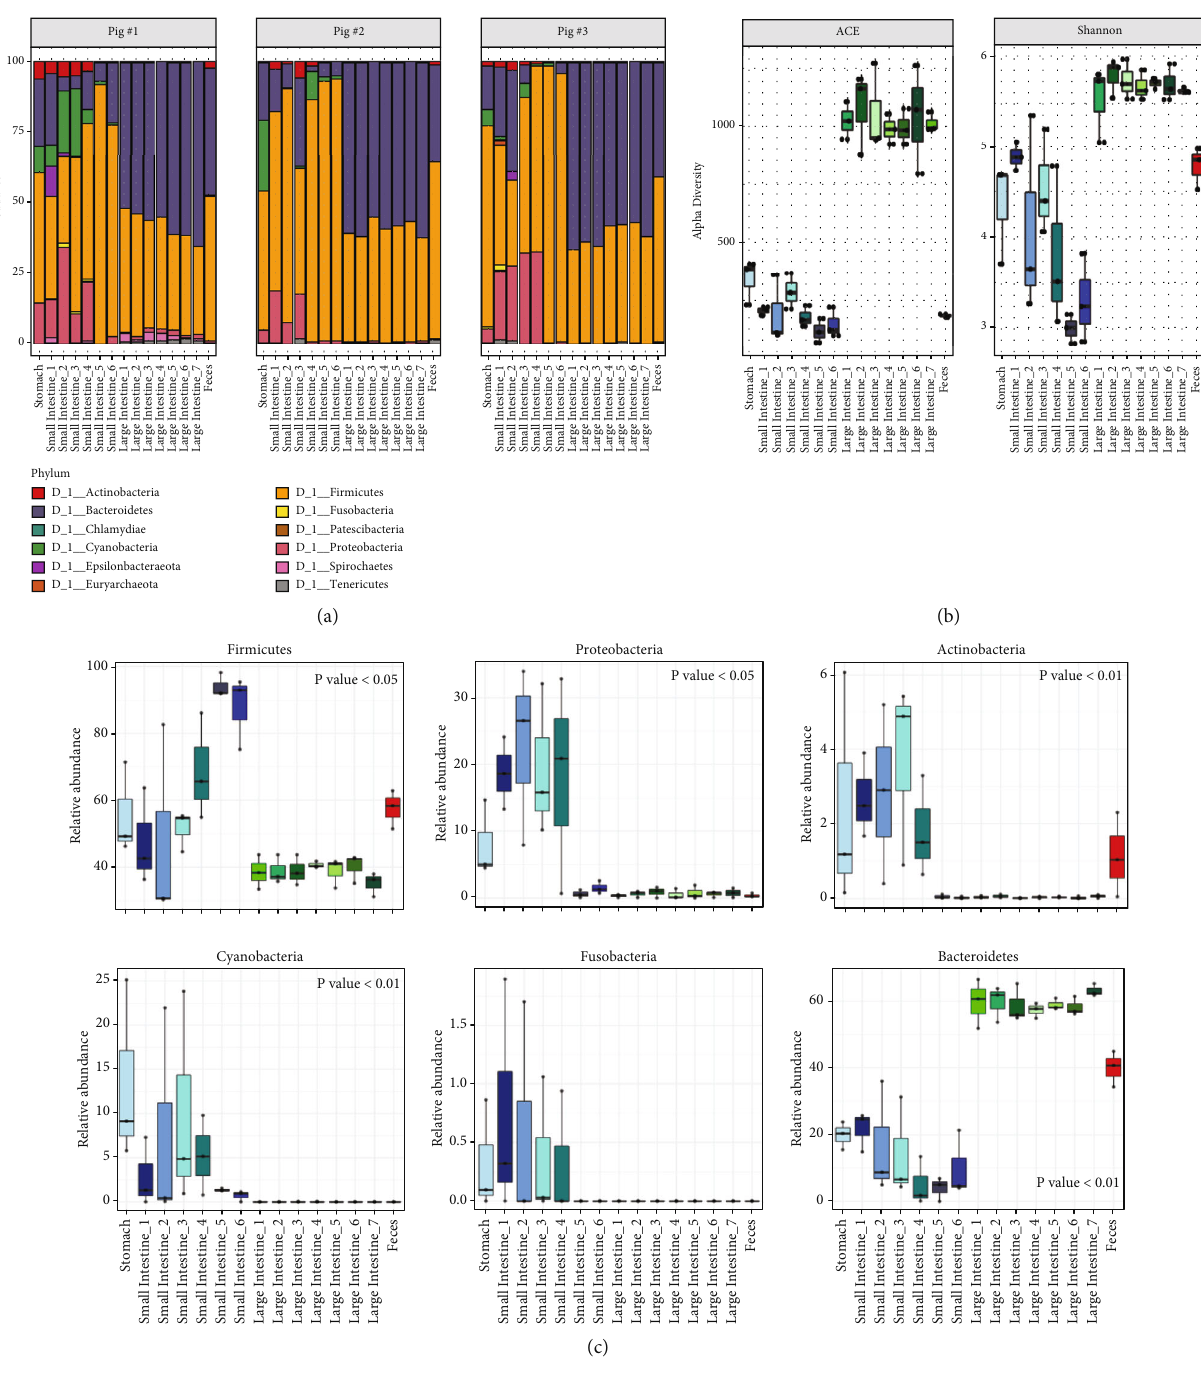
Figure 1: The microbial diversity at each location of the GI tract by α -diversity analysis. (a) The relative abundance of microbial phyla at each location of GI tract and feces. (b) Species richness and diversity were measured by the ACE and Shannon ( P < 0 : 05 ). (c) The relative abundances of the predominant intestinal microbes at phylum level which are Firmicutes, Proteobacteria, Actinobacteria, Cyanobacteria, Fusobacteria, and Bacteroidetes. The sampling locations within the GI tract were determined based on the anatomical feature: the stomach, the duodenum (small intestine_1), the jejunum (small intestine_2 ~ small intestine_5), the ileum (small intestine_6), the cecum (large intestine_1), the colon (large intestine_2 ~ large intestine_6), and the rectum (large intestine_7). The anatomical di ff erences between each location are shown in Figure